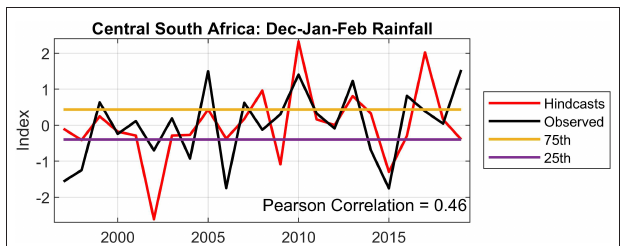
FIGURE 1 | Cross-validated hindcasts (red) vs. observations (black) for the Dec-Jan-Feb rainfall season of the farm located in the central interior of South Africa. The two horizontal lines respectively represent the 25th percentile value (purple) and the 75th percentile value (orange) of the climatological record. The Pearson correlation value between hindcast and observed is significant at the 98.6% level of confidence.